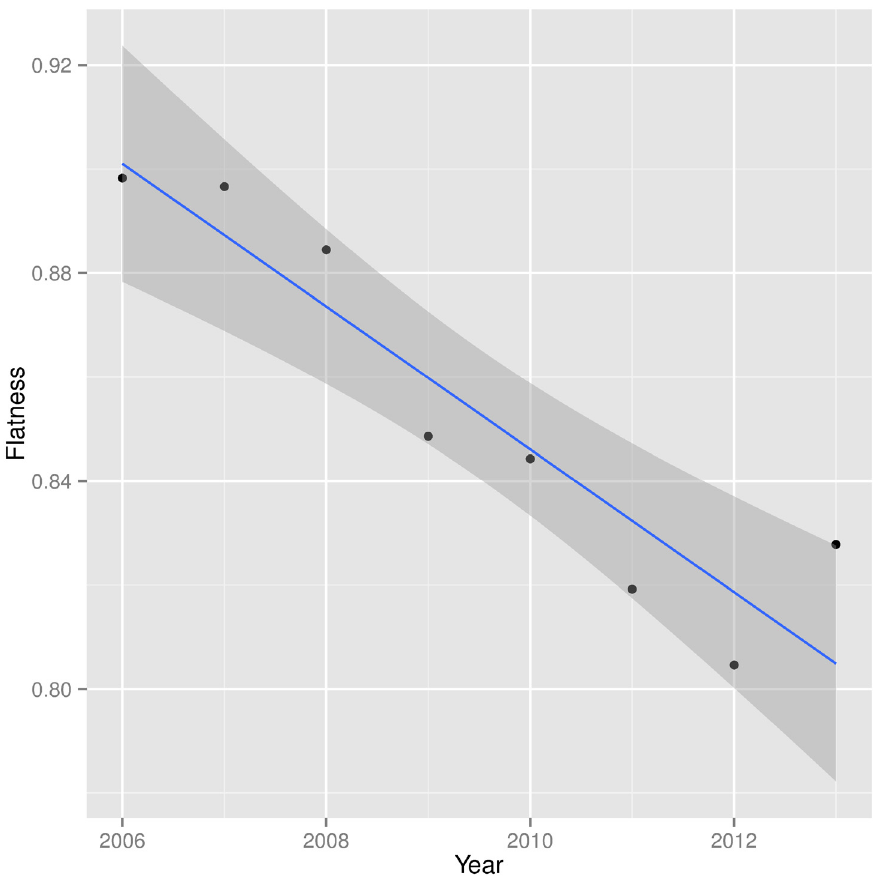
Fig 3. Flatness of the Kiva network. Flatness is defined as the fraction of unbiased country–pairs (|z| (cid:20) 2) under the null model. The flatness is measured by comparing the observed flow with the expected flow as described in the text. The line fit reveals a trend of decreasing flatness over the considered time frame